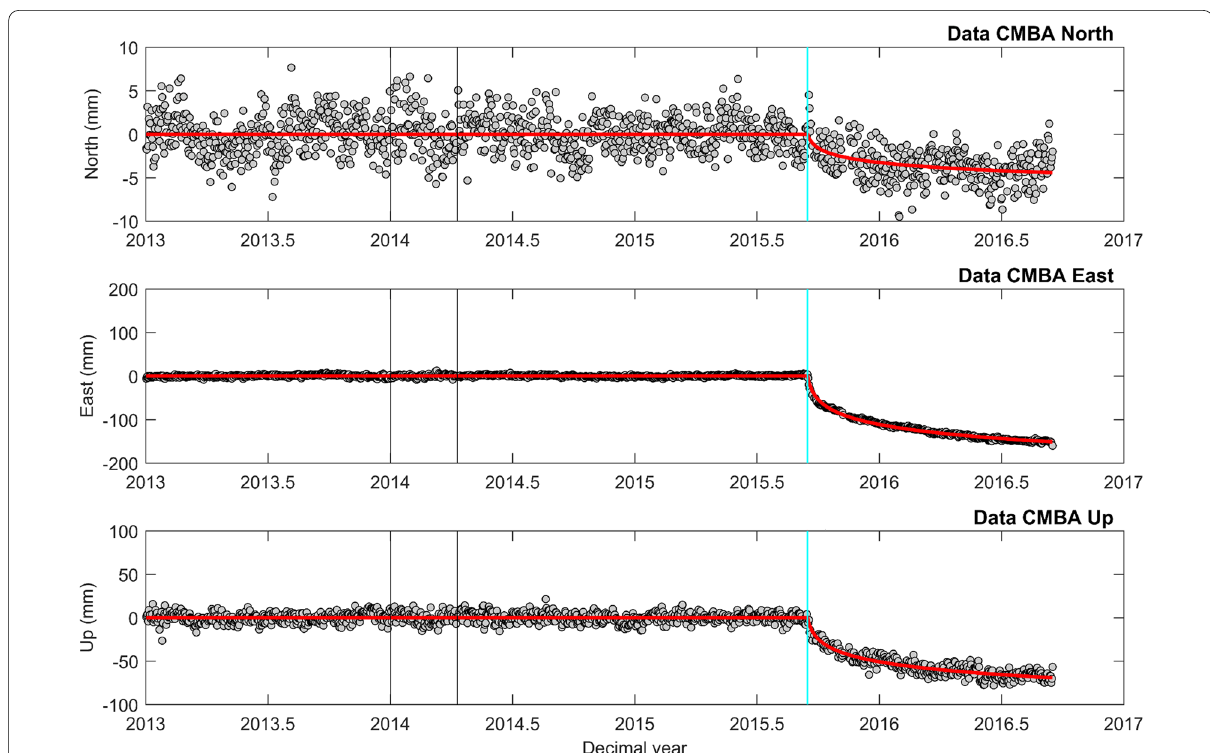
Fig. 3 GNSS position time series after removing linear trend and offsets and corresponding modeled